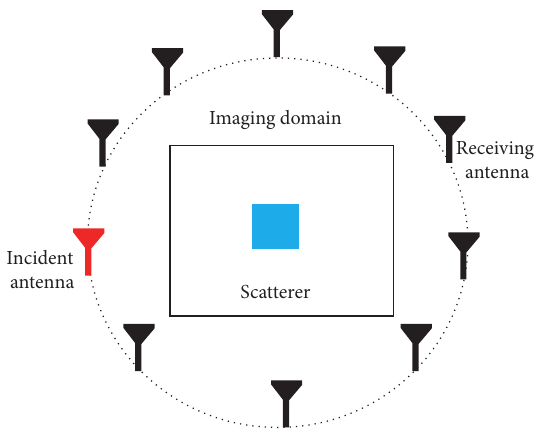
Figure 1: The simplified model of microwave